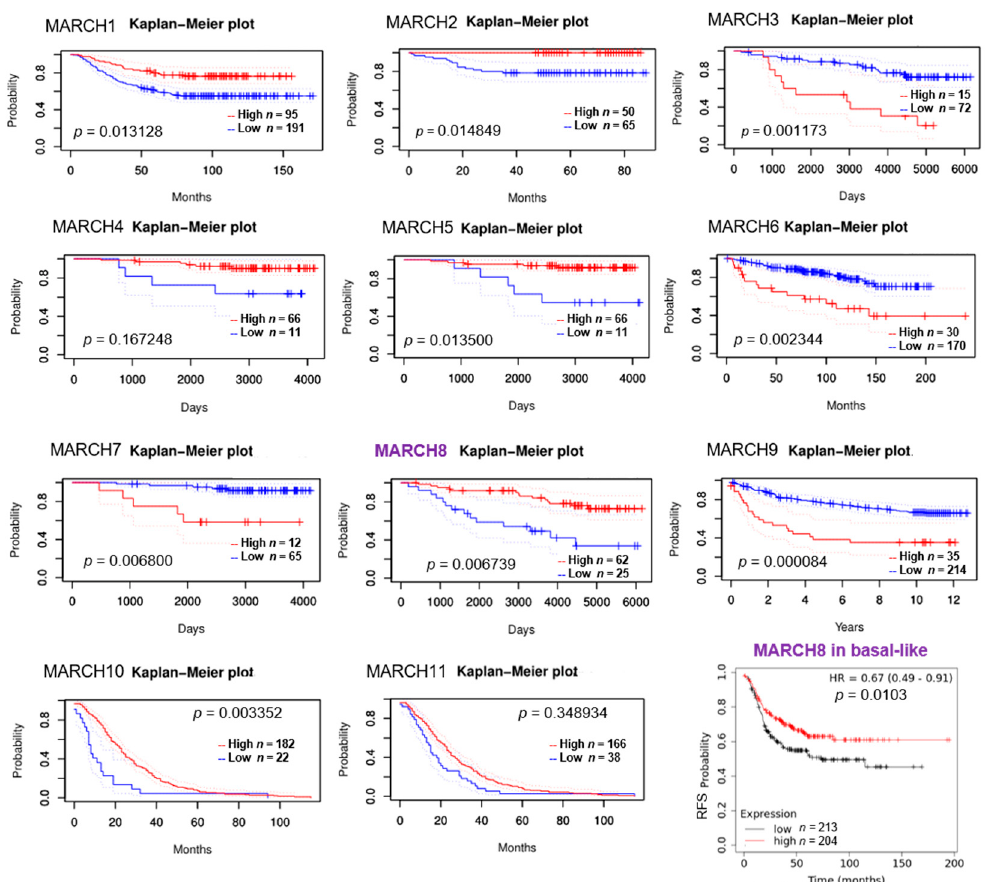
Figure 2. Association of MARCH8 expression and other family members with overall survival in breast cancer patients. A higher expression of MARCH8 and other MARCH family members (MARCH1, 2, 5, 10) is correlated with a higher overall survival probability for breast cancer patients according to the Prognoscan analysis. MARCH8 mRNA expression levels are also associated with relapse-free survival (RFS) of basal-like breast cancer (log rank p = 0.01).